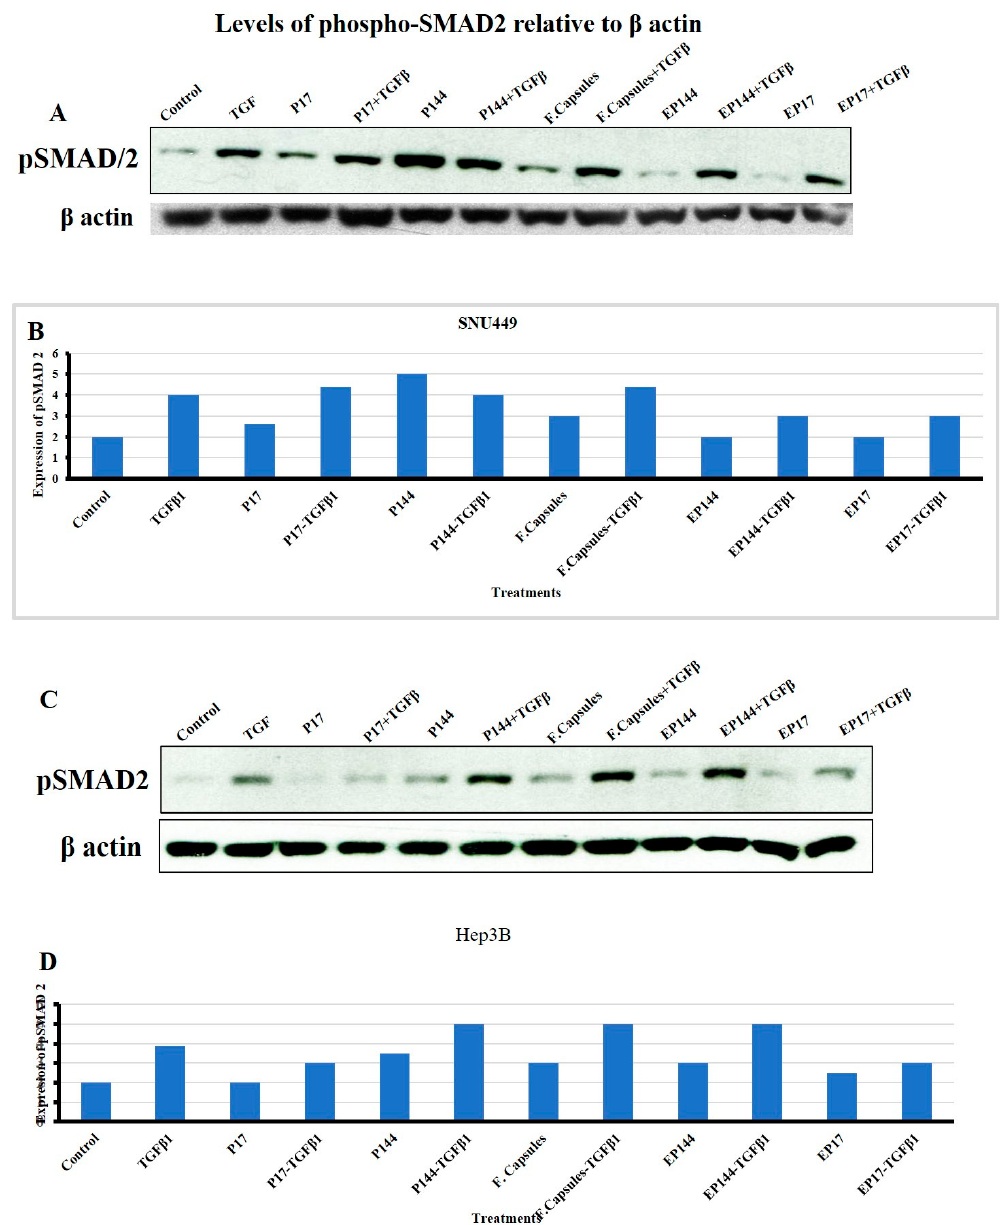
Figure 11. Evaluation of SMAD2 phosphorylation in SNU449 and Hep3B cells. ( A , C ) Western blot band of pSMAD2; beta-actin was analyzed as loading control. ( B , D ) Densitometric analysis of pSMAD2 levels after their exposure to several treatments for 6 h.